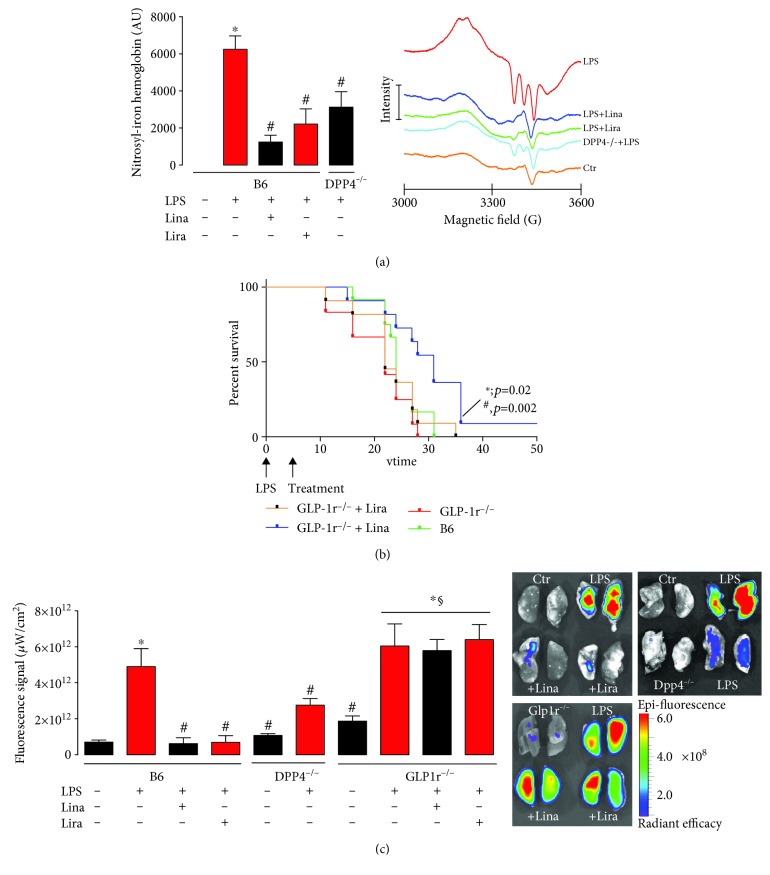
Antioxidant, anti-inflammatory, and vasculoprotective effects by the DPP-4 inhibitor or GLP-1 analog therapy in septic mice. (a) Whole blood Hb-NO levels were determined by electron paramagnetic resonance spectroscopy as a read-out of iNOS activity. (b) Mortality of endotoxemic mice was assessed by Kaplan-Meier curves recording the survival in dependence of time. 17.5 mg/kg LPS or solvent was administrated by i.p. injection. DPP-4 inhibitor (Lina: 5 mg/kg/d s.c. for 3 d) and GLP-1 analogue (Lira: 200 μg/kg/d s.c. for 3 d) treatment was started 6 h after the induction of endotoxemia. (c) Microvascular thrombosis was detected by fluorescence imaging using fluorescent microbeads in endotoxemic wild-type mice, DPP-4−/− mice, and GLP1r−/− mice. Representative images of lungs are shown beside the quantification. The data are mean ± SEM from 6-18 (a), 12 (b), or 4-6 (c) mice/group. ∗p < 0.05 vs. B6; #p < 0.05 vs. B6+LPS; §p < 0.05 vs. GLP-1r−/−. Adopted from Steven et al. [247] (with permission from John Wiley and Sons. Copyright © 2016, John Wiley and Sons).